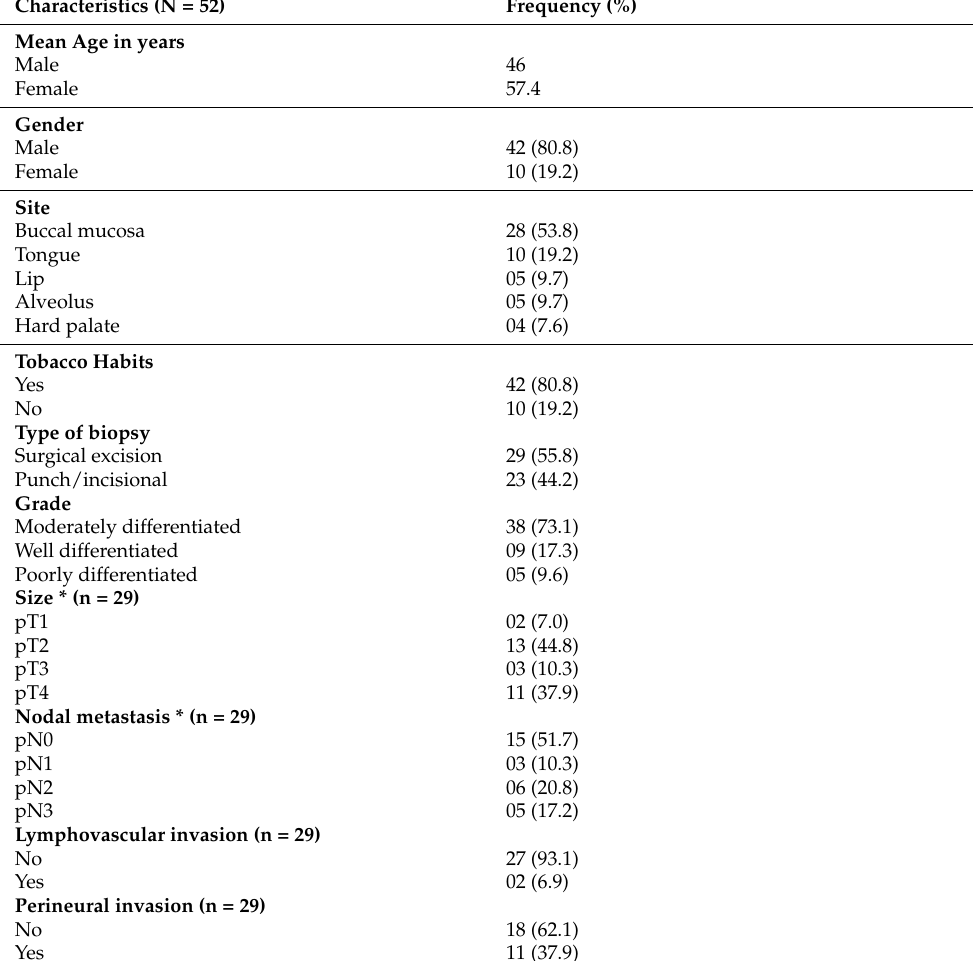
Table 1. Clinicopathologic characteristics of oral squamous cell carcinoma (OSCC)